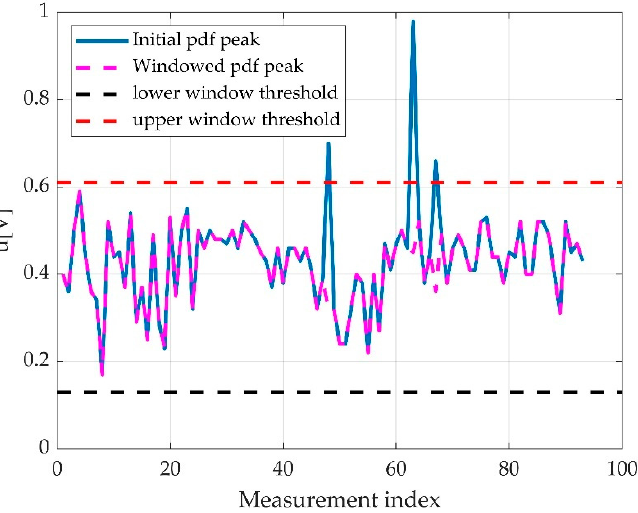
Figure 13. An unwindowed versus a windowed offset detection. It can be observed that in the windowed version, the variance is smaller.